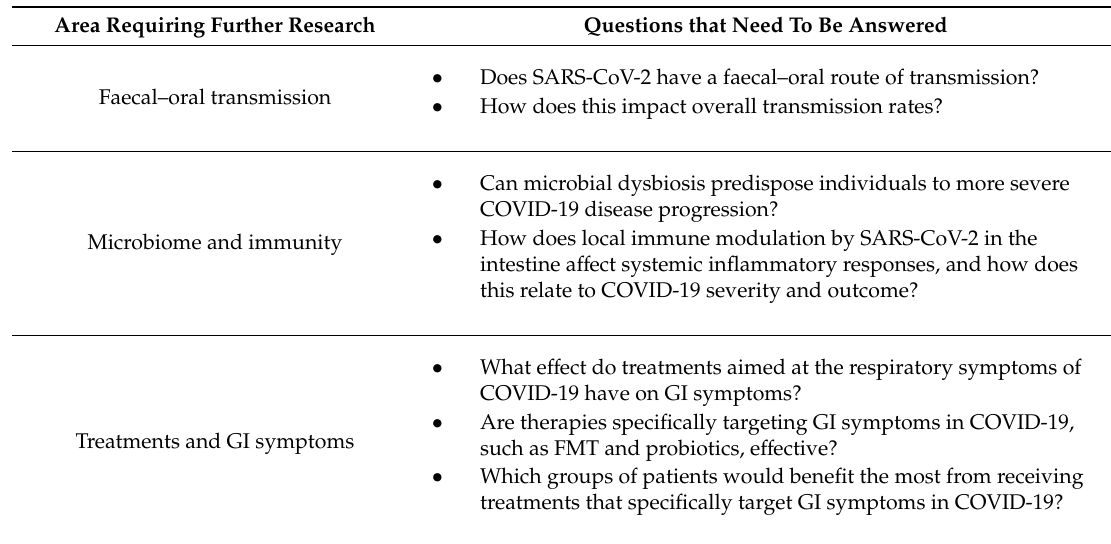
Table 4. Some of the areas where further research is required to answer key questions to improve understanding about SARS-CoV-2 and the